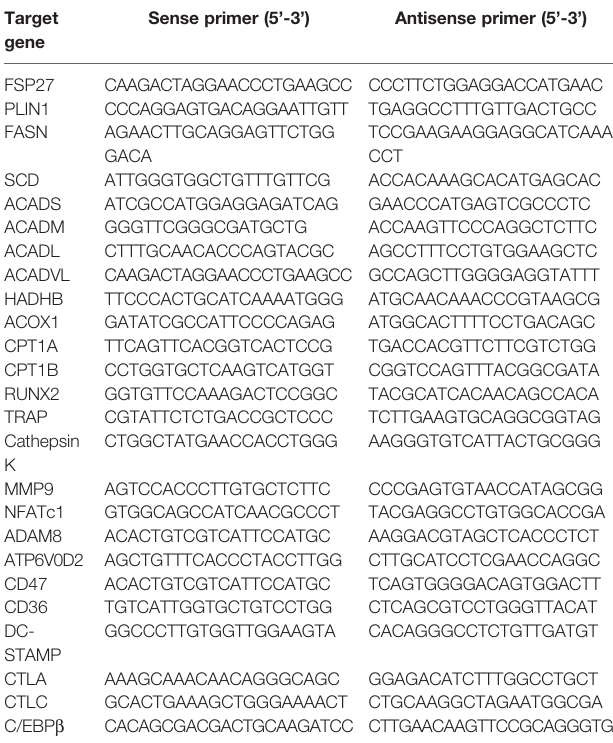
TABLE 2 | Primer sequences for